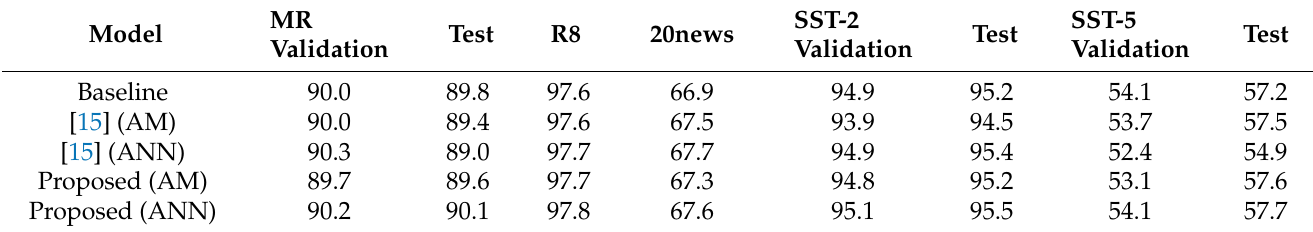
Table 4. Model performance on text classification with ELECTRA.